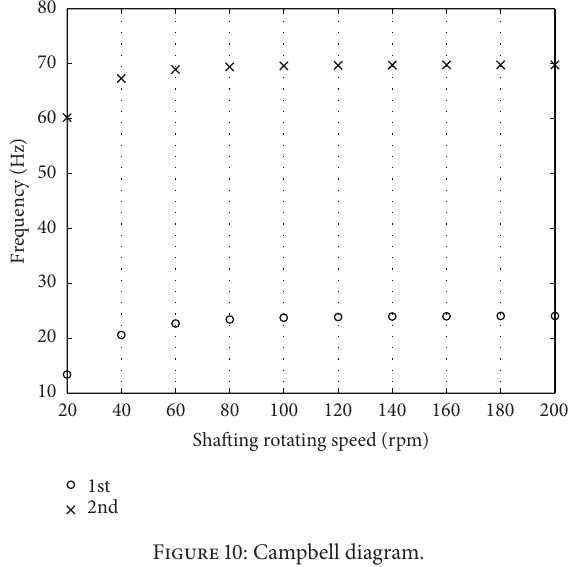
Figure 10: Campbell diagram.